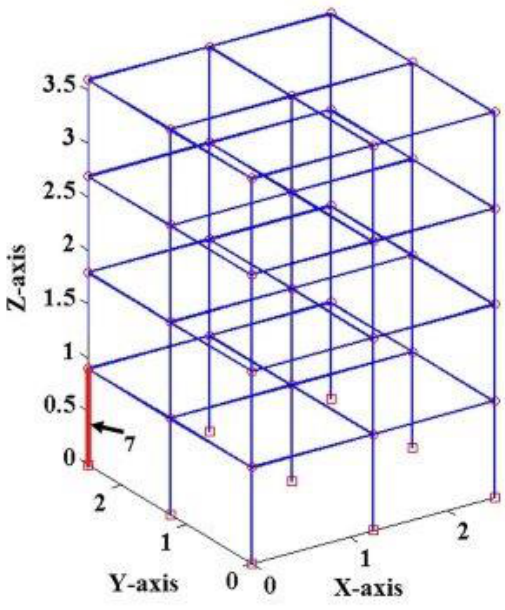
Figure 9. The damage scenario. Table 11 show PODEs, DMIs, and PDEs for the damage scenario. Furthermore, a com- parison between the proposed ESMA and the original SMA is shown. Herein, the simulated mode shapes and frequencies consist of 5% and 2% measurement noise, respectively. Table 11. PoDEs, PDEs, and DMIs for the four-story steel